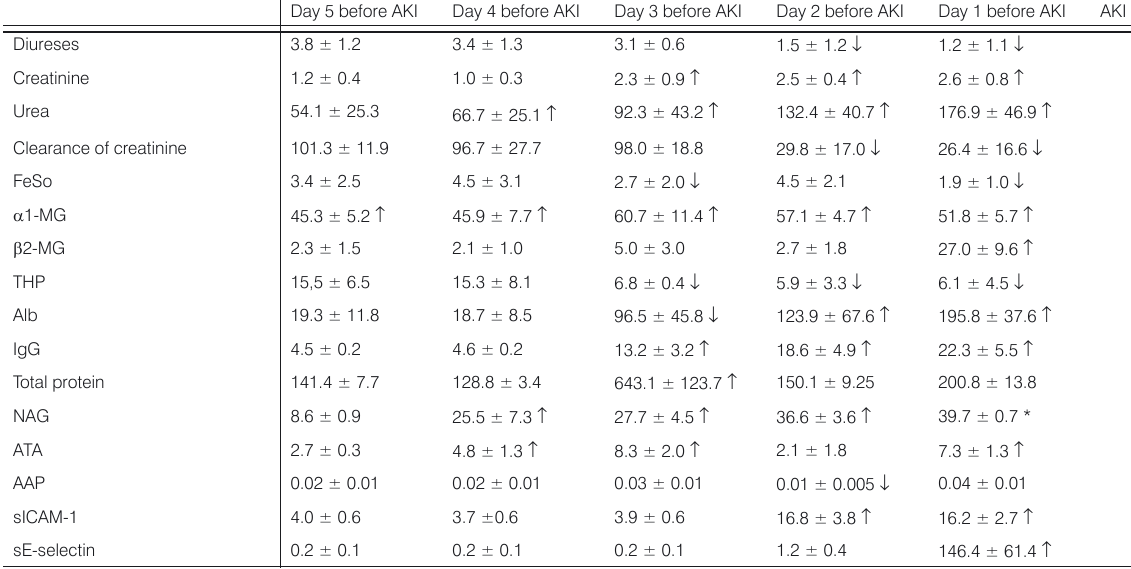
Table 2. Significant chronological courses for the examined